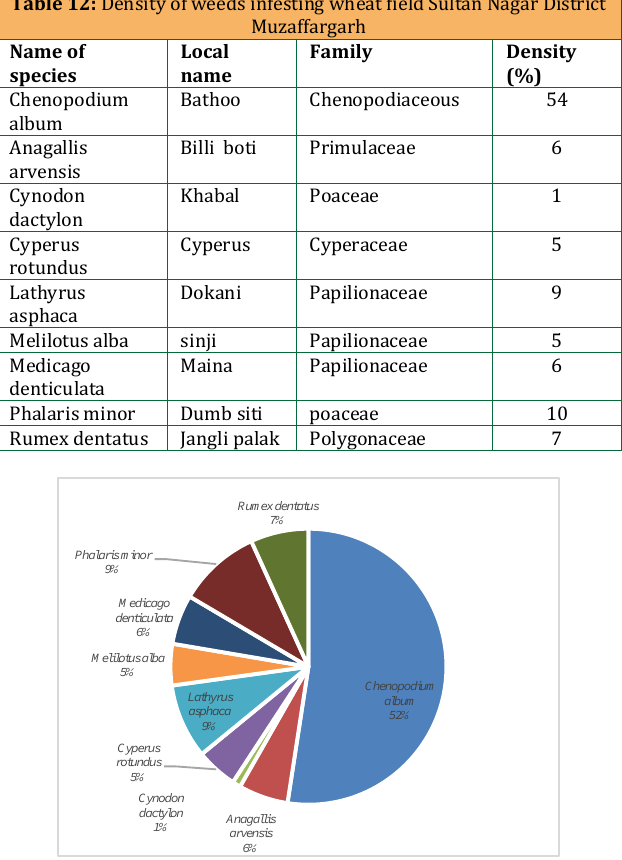
Figure 12: Density of weeds infesting wheat field Sultan Nagar District